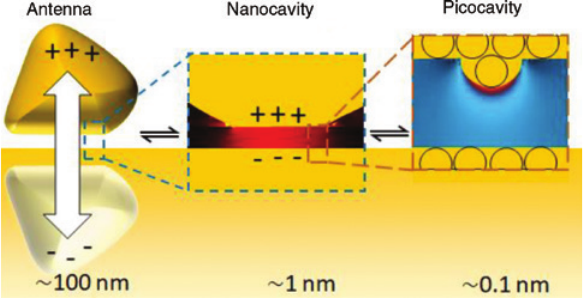
Figure 4: Effective wavelength scales between free-space photons, coupled via antennas into nanogap modes, which can then couple to atomic-scale protrusions (“picocavities”). Reprinted from Ref.